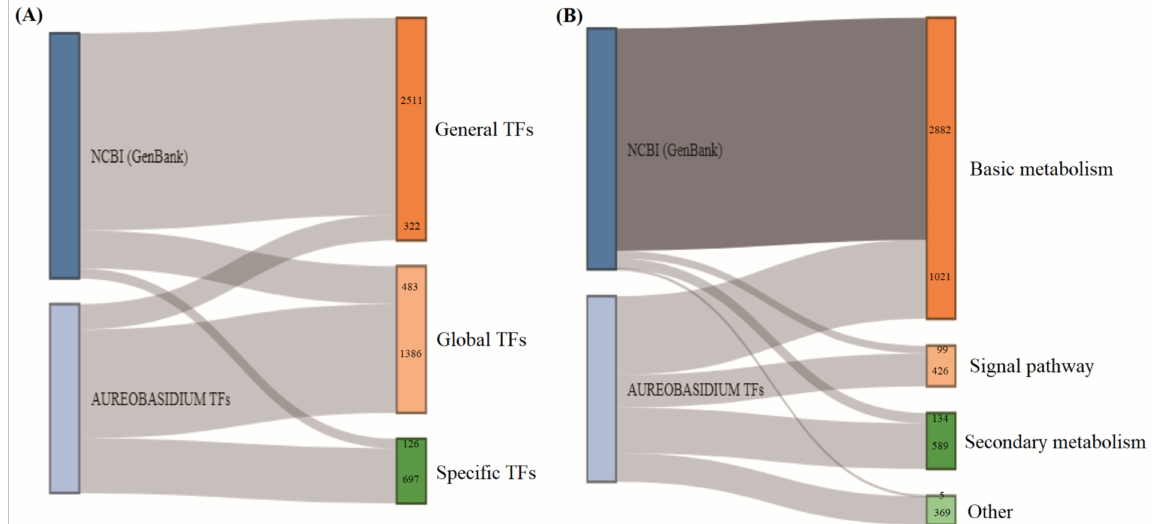
Figure 7. Comparison of the TFs numbers of Aureobasidium spp. in the NCBI (GenBank) and the ATFDB databases. ( A ) Comparison of the NCBI (GenBank) and the ATFDB databases at type-level of TFs classifications. ( B ) Comparison of the NCBI (GenBank) and the ATFDB databases at the metabolism-level of TFs